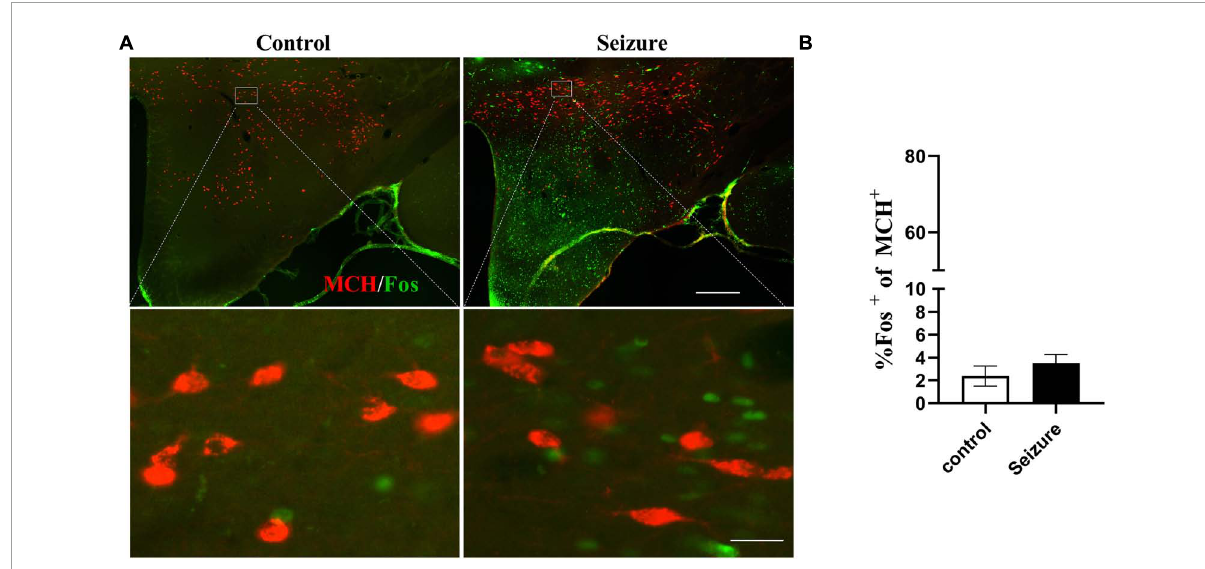
FIGURE4 Pilocarpine-induced seizures did not cause significant activation of MCH neurons. (A) Representative images of MCH (red) and Fos (green) immunofluorescent staining in the hypothalamus of control or seizure rats; bar: 500 µ m in the upper panel and 30 µ m in the lower panel. (B) Bar graph showing the proportion of MCH neurons that were Fos + . n = 4 rats for each group, Student’s t -test.